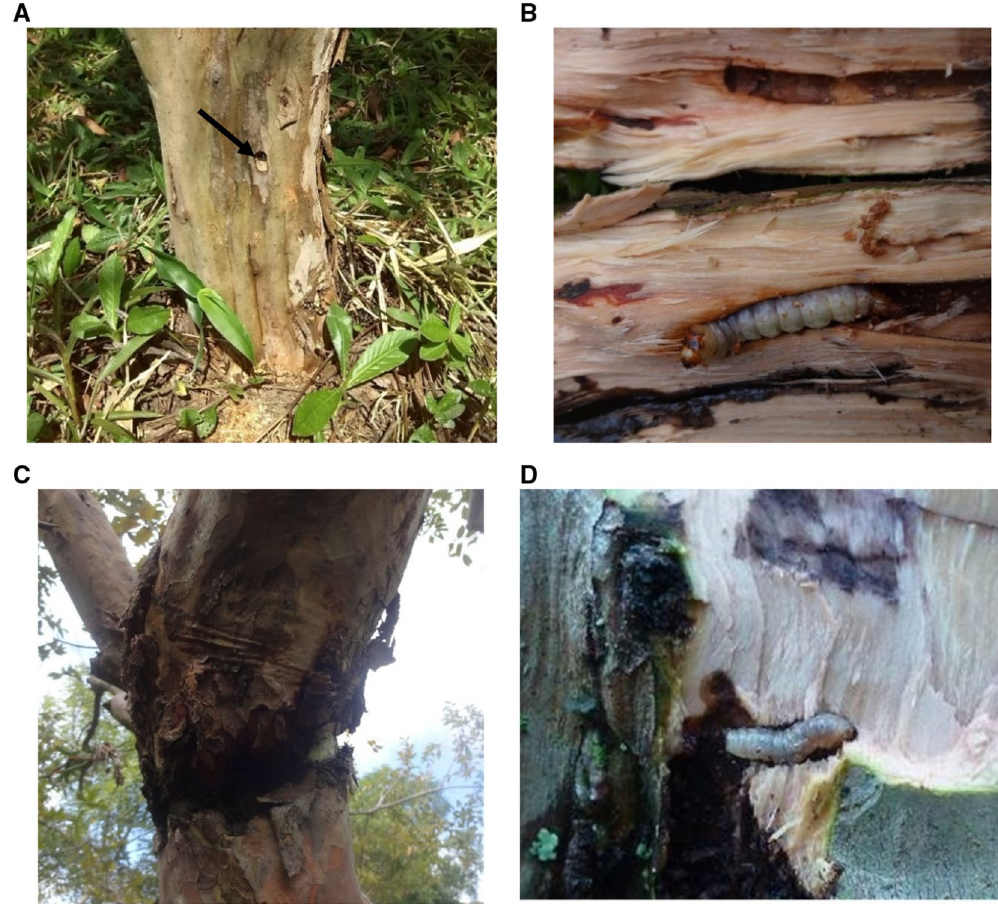
Figure 1. a Presence of S. ampliophilobia inside a guava tree due to observing a typical capped hole made by this insect. b S. amphoraphilobia larva inside a sectioned guava tree. c Presence of C. theobromae . d C.